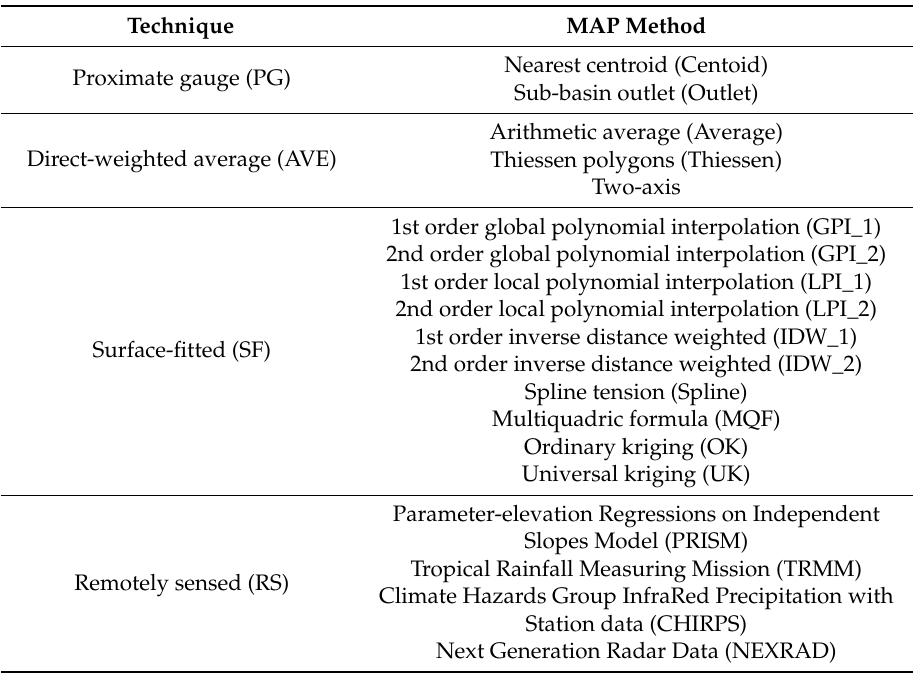
Table 2. List of different mean areal precipitation (MAP) methods and associated abbreviations used in the